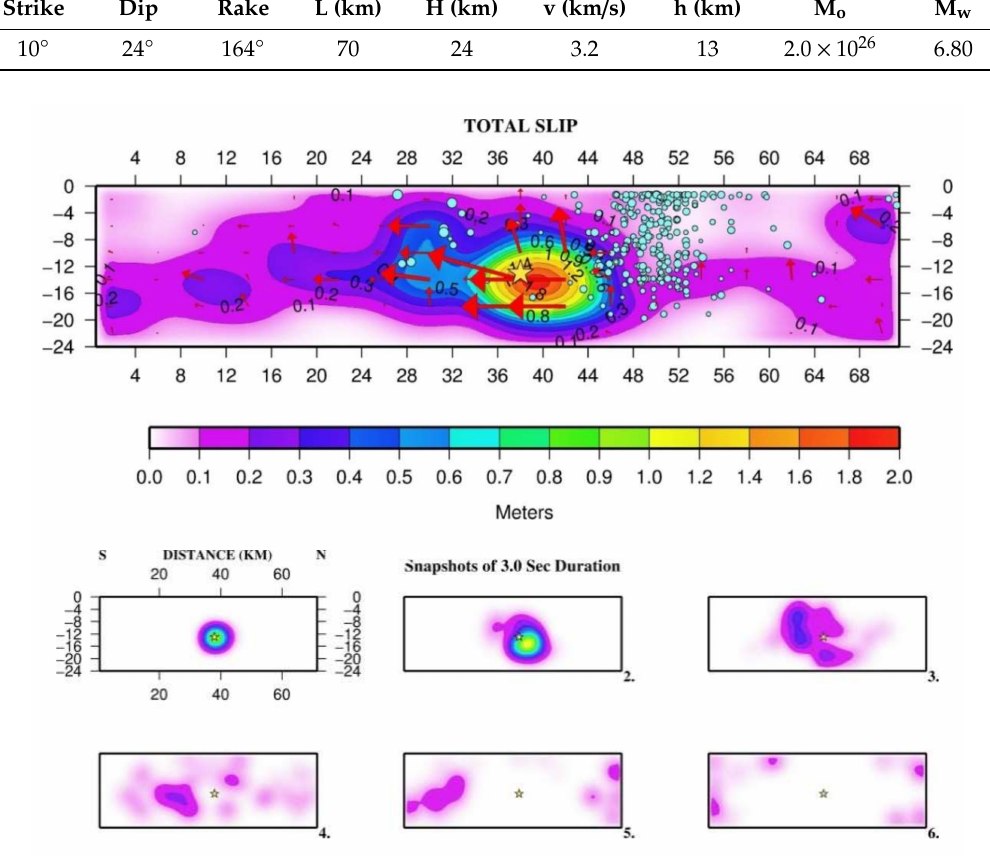
Figure 17. Space (upper panel) and space-time (lower panel in snapshots of 3 s in duration) variation of the co-seismic slip during the 25 October 2018 mainshock (section from south to north); star is relocated epicenter. Red arrows show slip direction, length of arrows scales with amount of slip (black figures in m). Blue circles are relocated earthquakes in the premonitory intermediate-term (1 August 2016–1 May 2017) transient swarm. The swarm area delineates the asperity to the north. Within the first 6 s the rupture propagated northwards but stopped in the boundary with the swarm